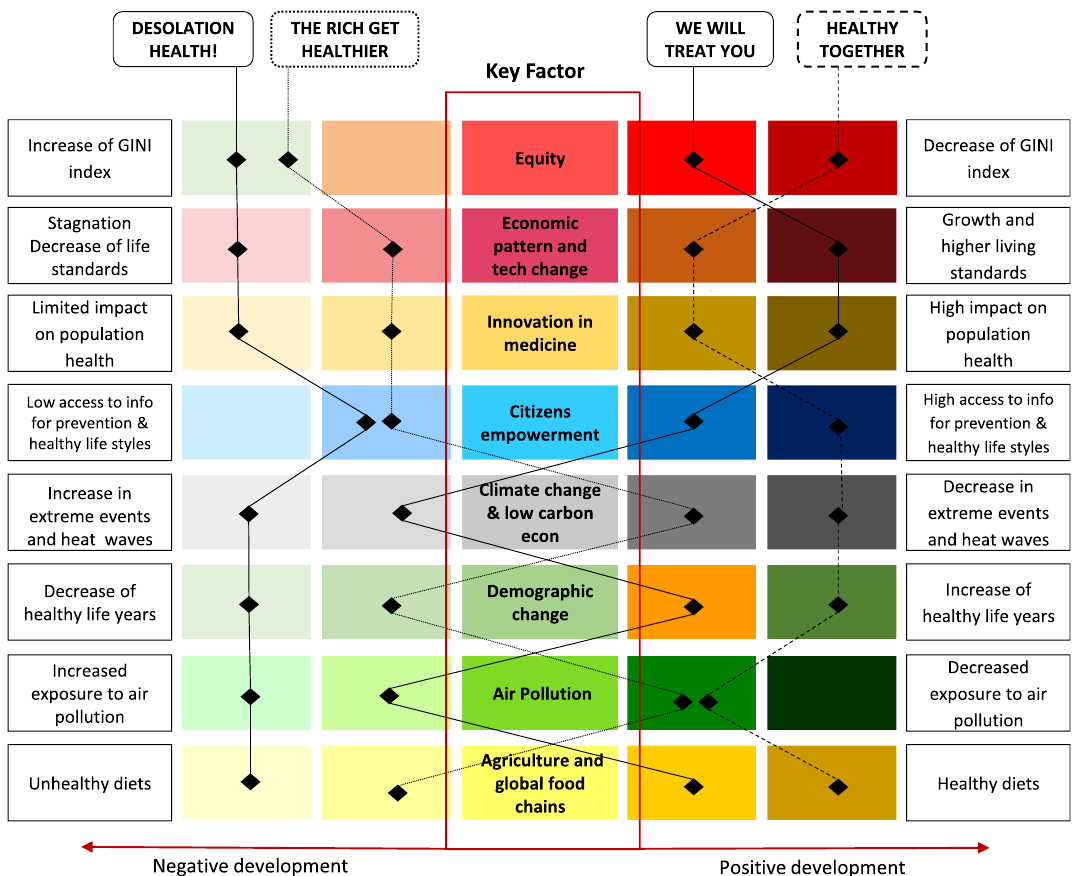
Fig. 2 Overview of FRESHER Scenarios and their key characteristics [16]